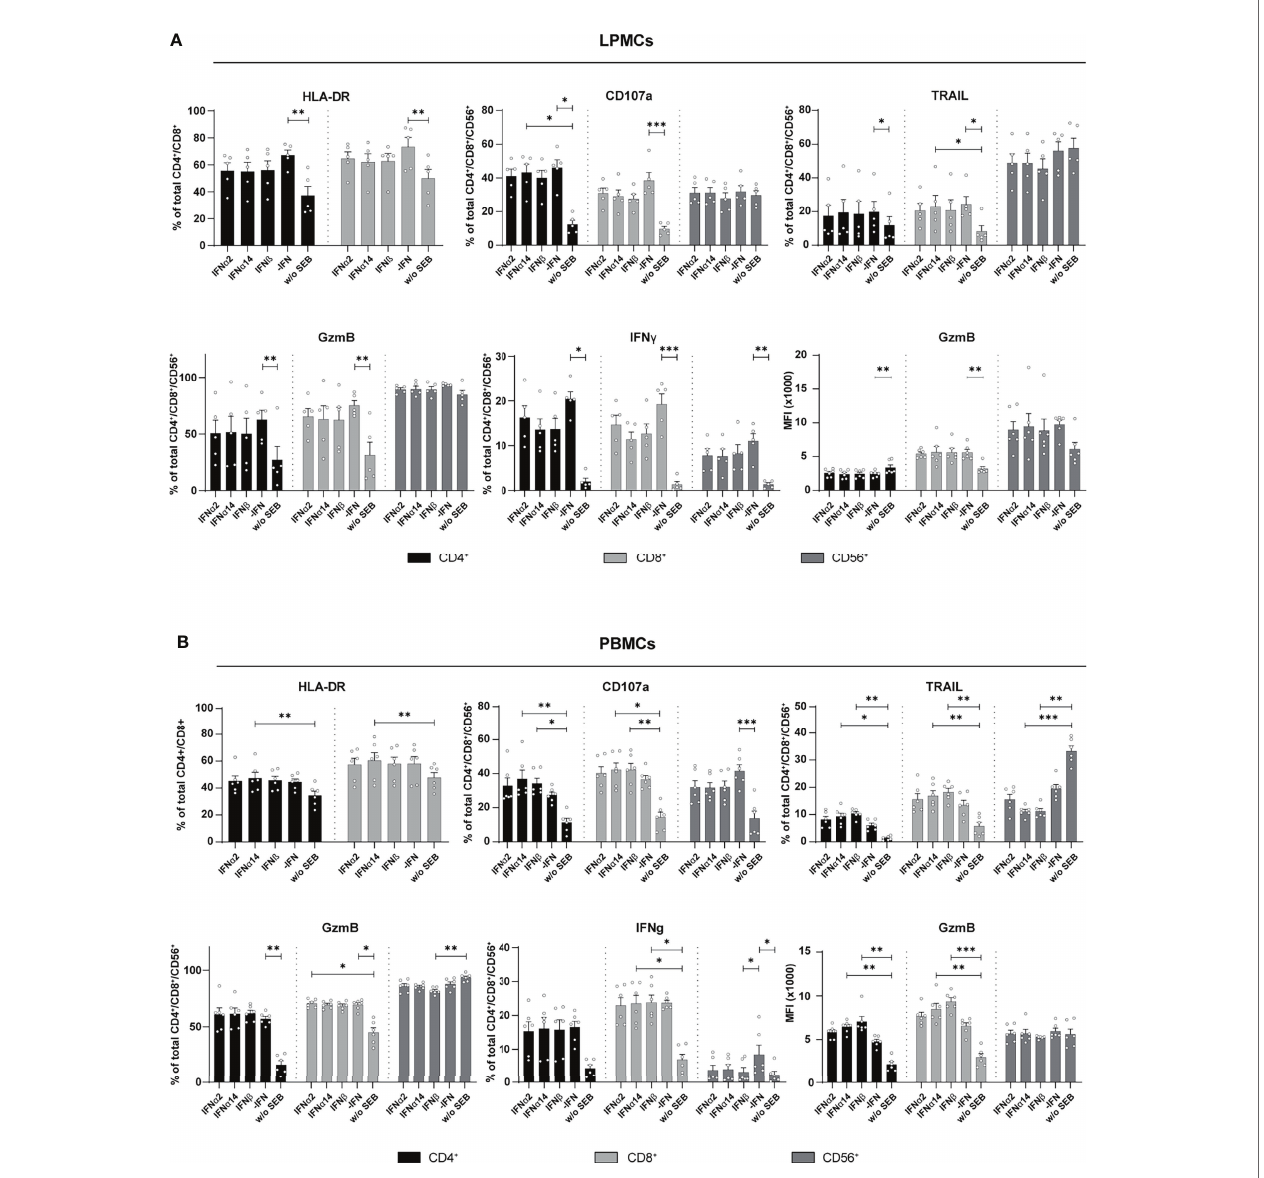
FIGURE 4 | Cytokine expression after IFN treatment of LPMCs, and PBMCs from healthy individuals. (A) LPMCs and (B) PBMCs from healthy individuals were stimulated as described before with SEB and treated with either 2000 U/ml IFN a 2, IFN a 14, IFN b , or without IFN (-IFN). frequencies of HLA-DR, CD107a, TRAIL, GzmB, and IFN g expressing cells as well as GzmB expression per cell shown as MFI after treatment of SEB-treated PBMCs and LPMCs. Mean values ± SEM are shown for (A) n=5 and (B) n=6. Statistical analyses were done by using Friedman test and Dunn ’ s multiple comparison test. ***, P < 0.001; **, P < 0.01; *, P <